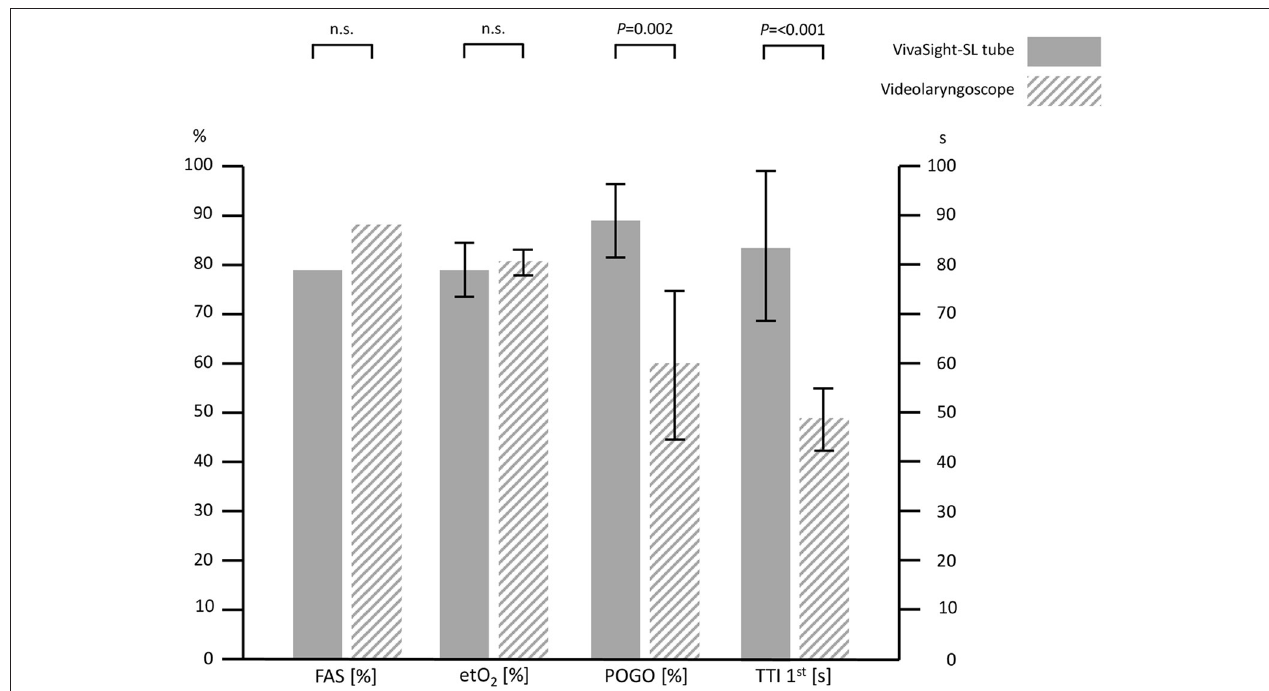
FIGURE 3 | Overview of success rate, oxygenation, visualization, and duration for VivaSight and videolaryngoscopy. FAS, first attempt success rate; etO 2 , end-tidal oxygen fraction after intubation; POGO, percentage of glottis opening scale; TTI 1st, time to intubation with success in the first attempt. Error bars indicate 95% CIs; n.s., not statistically